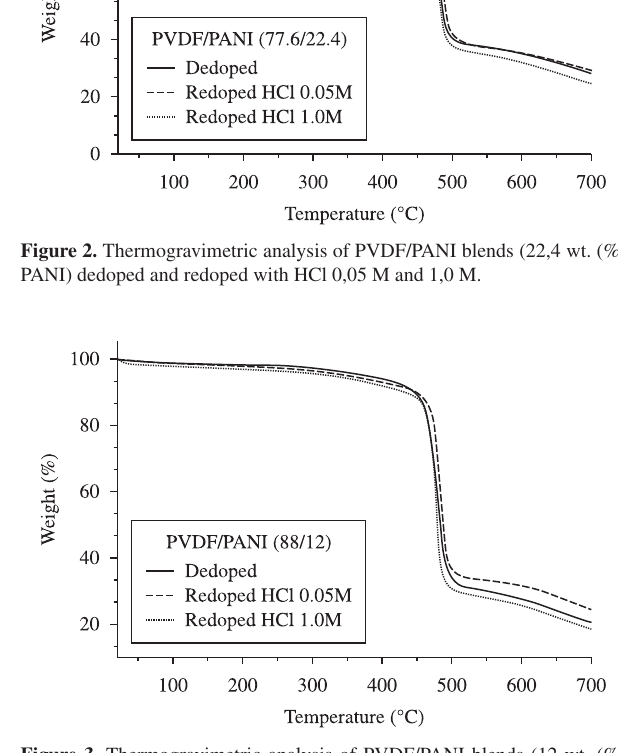
Figure 3. Thermogravimetric analysis of PVDF/PANI blends (12 wt. (%) PANI) dedoped and redoped with HCl 0,05 M and 1,0